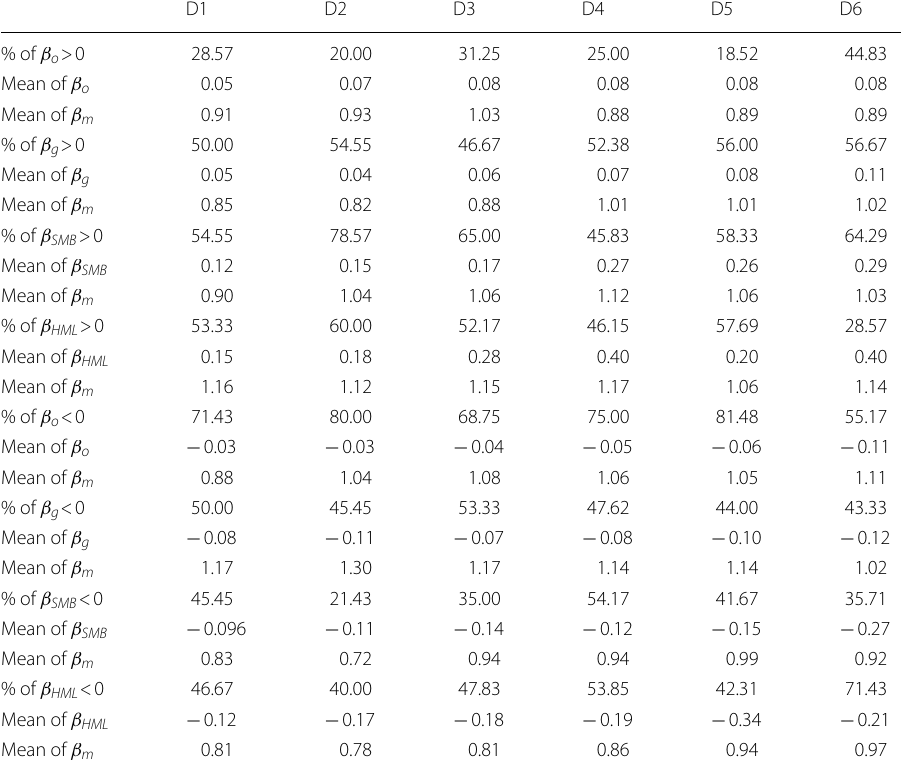
Table 4 Synthesis of Betas signs and means D1